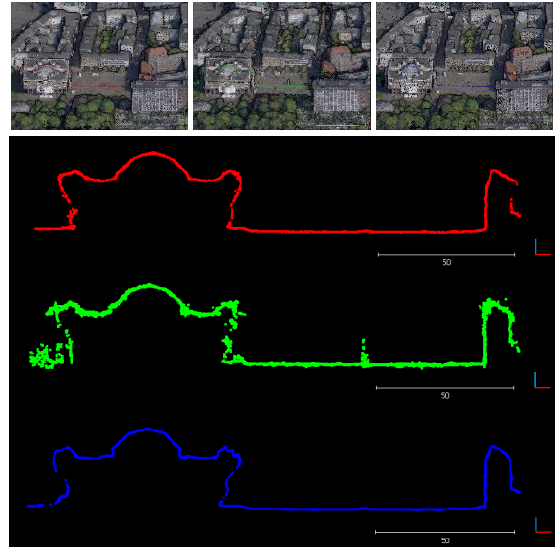
Figure 3: DIM results (PS, Pix4D, ReCap, respectively) on an AOI of the block (above). Three profiles of the dense point clouds